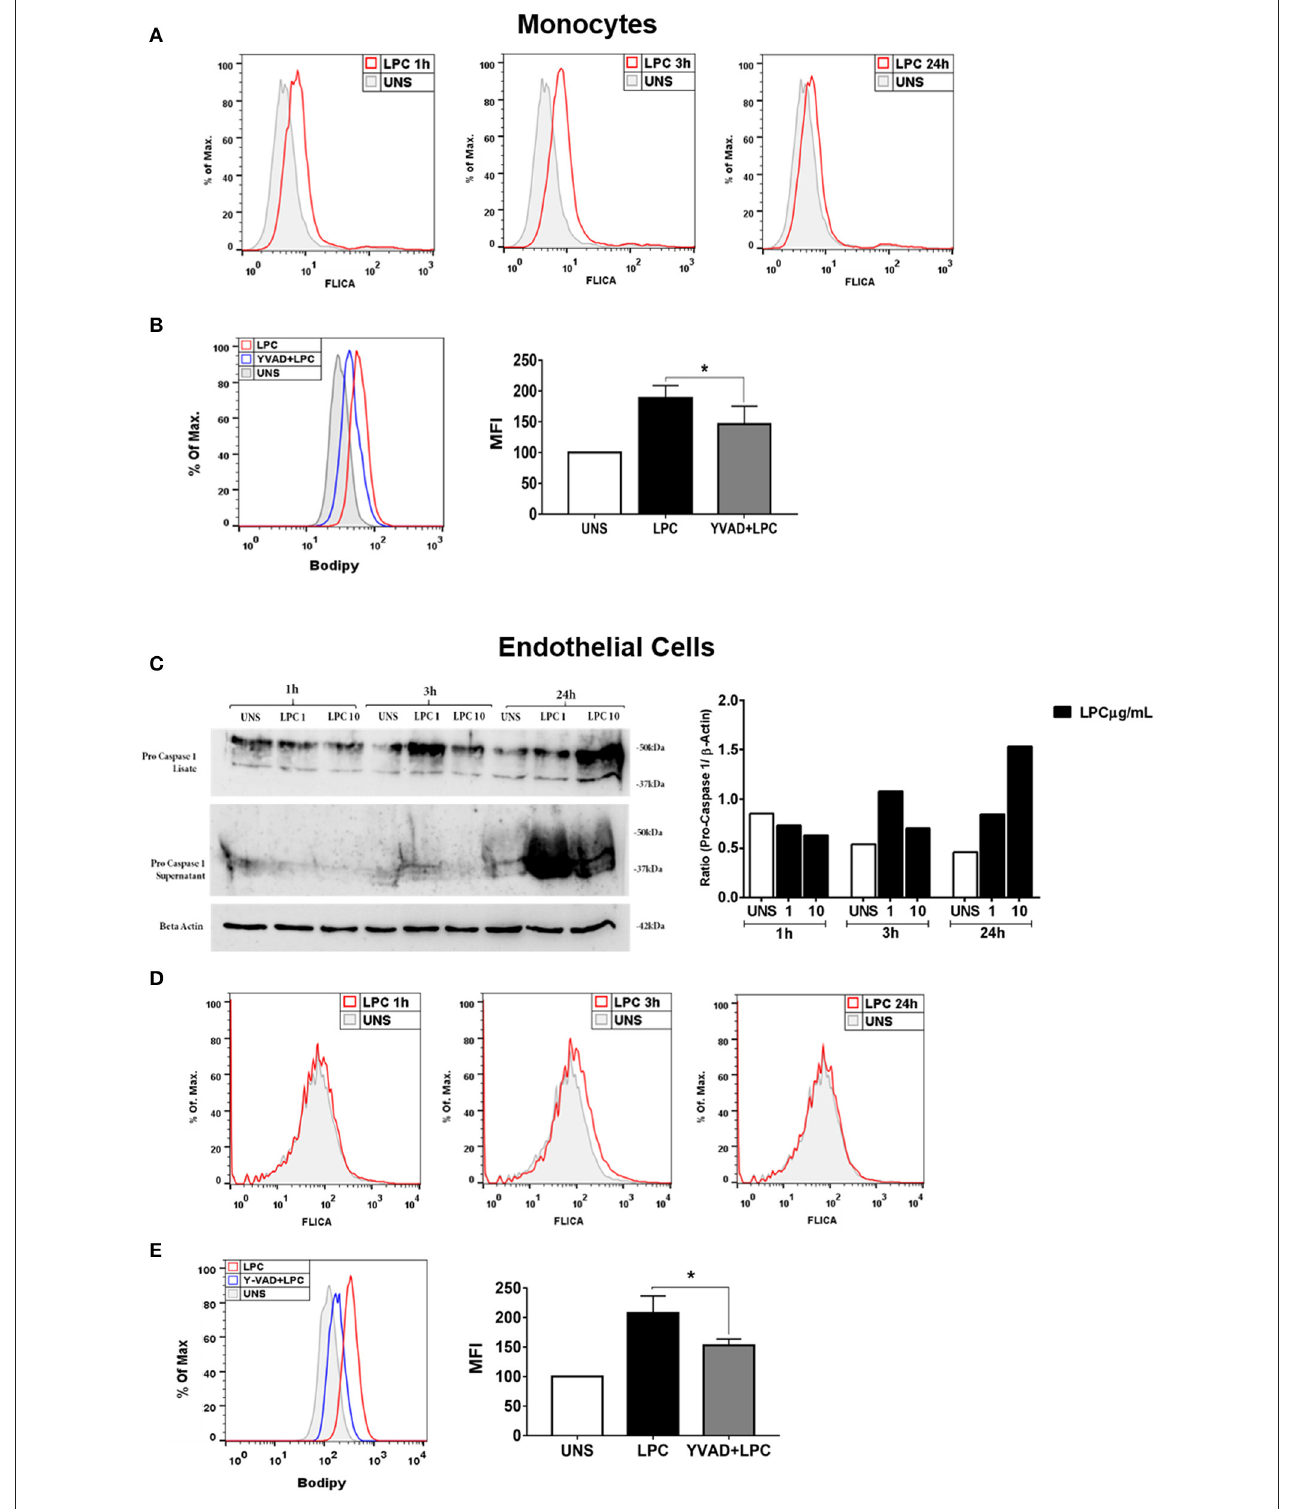
FIGURE 3 | Lysophosphatidylcholine (LPC) induces activation of caspase-1 and foam cell formation in a caspase-1 activation-dependent manner. (A) Human monocytes and (D) human endothelial cells were stimulated with 1 µ g/ml of LPC for 1, 3, and 24h; the cells were stained with FAM-YVAD-FLICA to determine